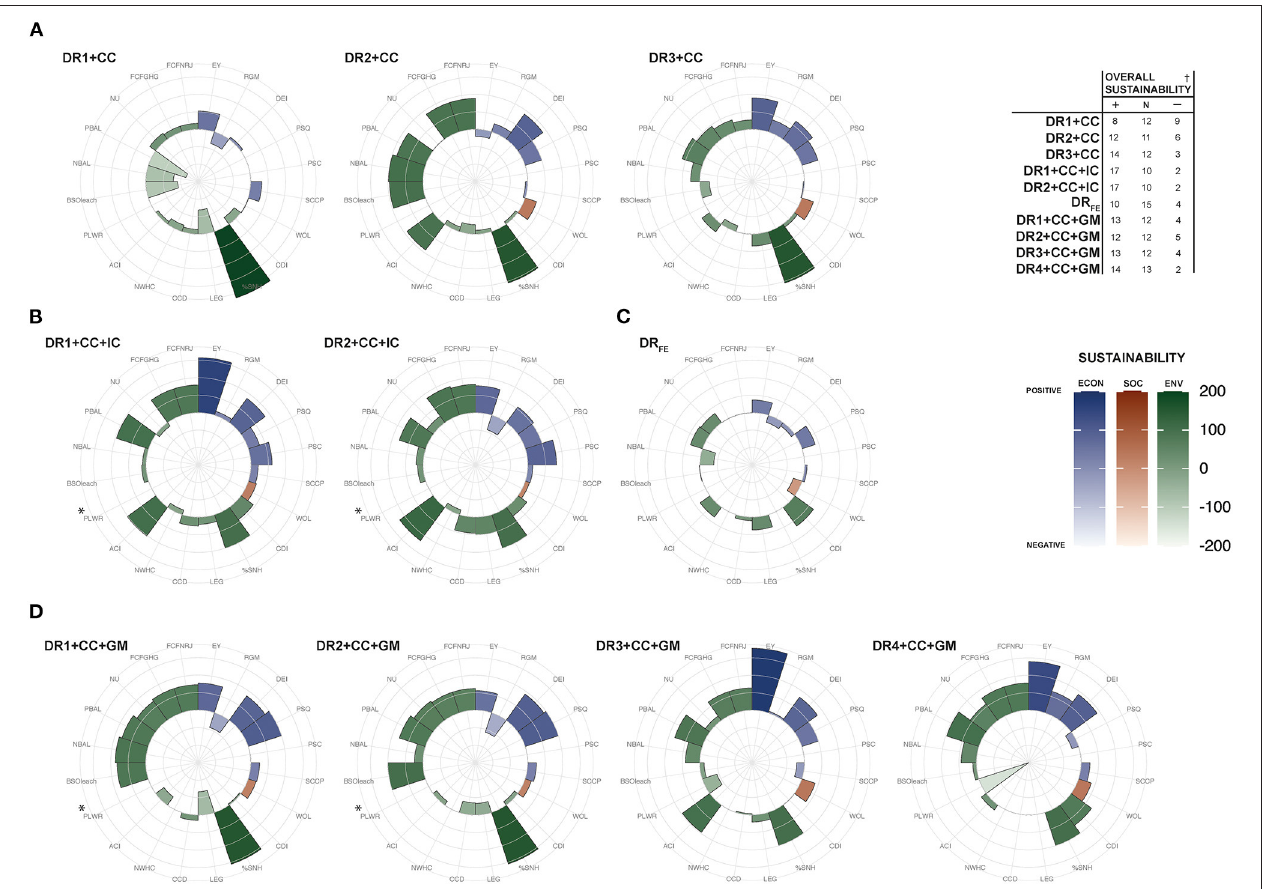
FIGURE 3 | Schematic diagrams of the sustainability framework assessment for 10 diversified crop rotations in the (A) group including cover crops (DR + CC), (B) group including cover crops and intercrops (DR + CC + IC), (C) diversified field experiment (DR FE ), and (D) group including cover crops and green manures (DR + CC + GM). The different colors reflect the three dimensions of sustainability (ECON, economic; SOC, social; ENV, Environmental). An asterisk in the PLWR indicator designates a lack of data to calculate the indicator, so it was set to zero. In the overall sustainability table, the total number of positive ( + ), neutral (N) and negative (–) indicators are presented for the overall sustainability of the SAF assessment. † indicates that all the indicators were counted (including the ones that were set to zero, see Supplementary Table 1 ). EY, Energetic yield; RGM, Average gross margin at rotation level; DEI, Total input/turnover; PSQ, Product standard quality required by the sector/market; PSC, Proportion of short food supply chain and local distribution; SCCP, Supplier contribution to profitability; WOL, Work overload; CDI, Crop diversity Index; %SNH, % Semi natural habitat; LEG, % Legumes in rotation; CCD, Crop-cultivar diversity; NWHC, Proportion of crops harvested in wet conditions; ACI, C input during the rotation; PLWR, Pressure on local water resources; BSOleach, Bare soil during drainage periods; NBAL, Surface N balance; PBAL, Surface P balance; NU, Nitrogen use; FCFGHG, Total fuel consumption at farm level for global warming potential calculation; FCFNRJ, Total fuel consumption at farm level for fossil energy use